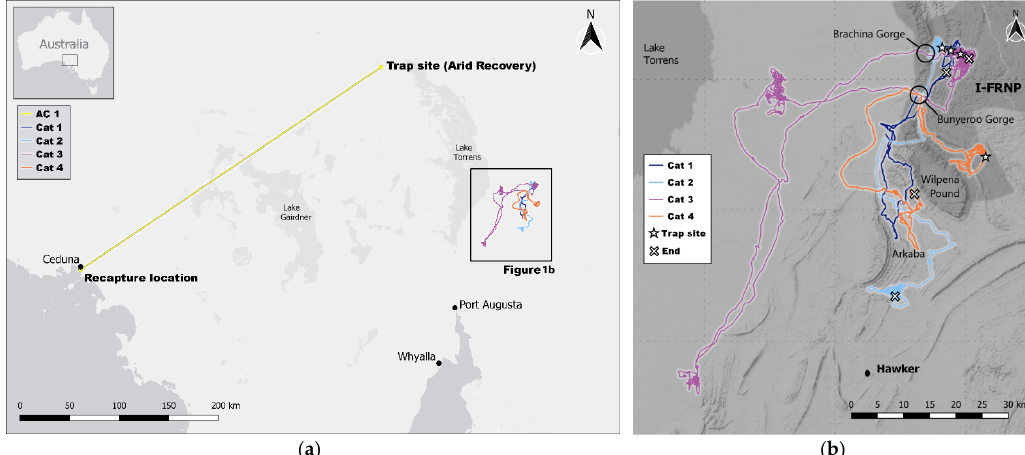
Figure 1. ( a ) Movement of feral cat (AC1) collared at Arid Recovery, South Australia, with trap site and site of last capture. The location of ( b ) is indicated with the box; ( b ) Movement tracks of the four feral cats collared in the Ikara-Flinders Ranges National Park (IFRNP), South Australia, with trap sites ( ☆ ) and site of last capture/death (X). Dark blue = Cat 1; Light blue = Cat 2; Purple = Cat 3; Orange = Cat 4. The location of Hawker township, Arkaba Conservancy, Wilpena Pound and the two gorges incising the Heyson Range are shown. The National Park is highlighted in dark grey. Base image: ( a ) ESRI Grey/QGIS; ( b ) Stamen/QGIS [37]. Map created using the Free and Open Source QGIS.